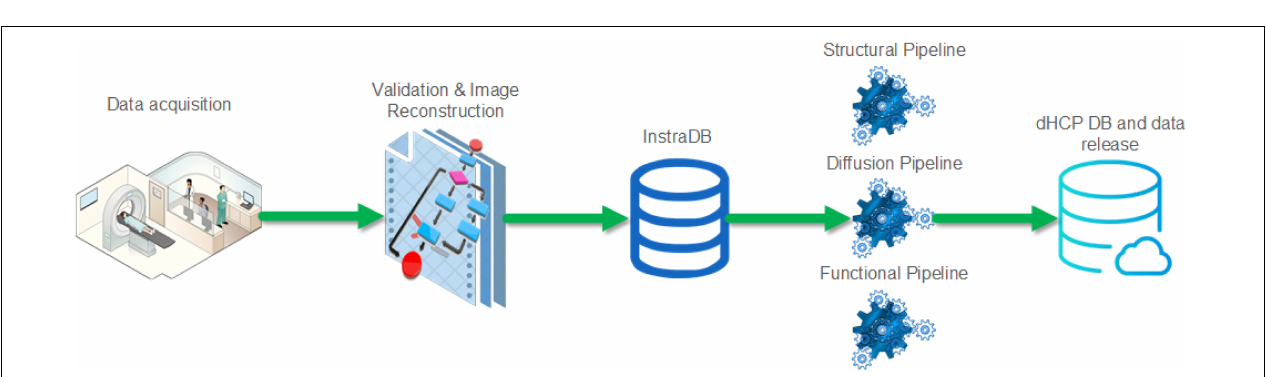
FIGURE 1 | Histograms showing ages for boys and girls at (A) birth and (B) postnatal MR imaging.